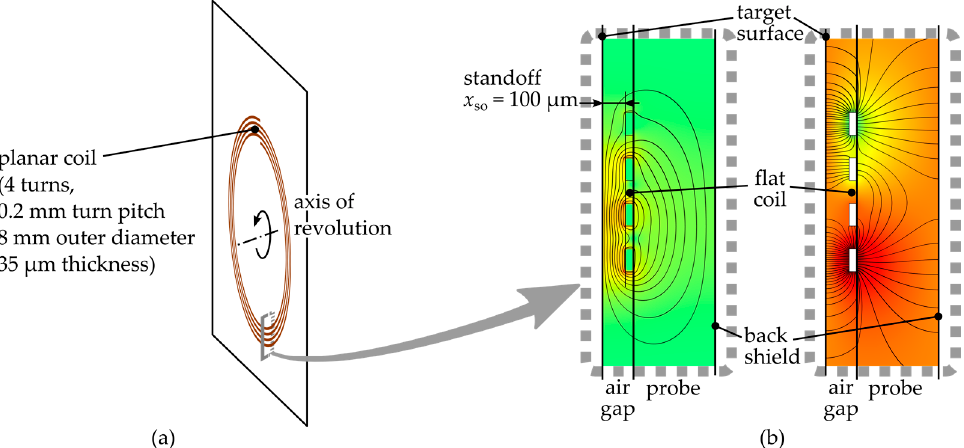
Figure 2. ( a ) The coil geometry used in this study. ( b ) Magnetic (left) and electric (right) field lines of the mode corresponding to the SRF of the